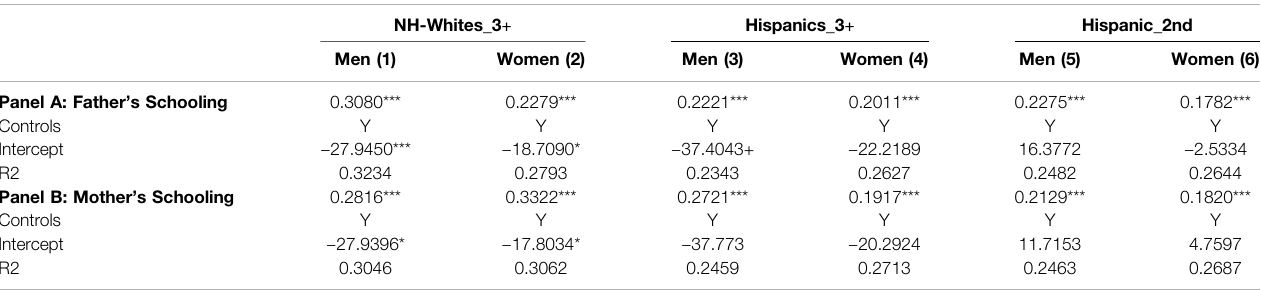
TABLE 2 | Correlation coef fi cients of parent-child